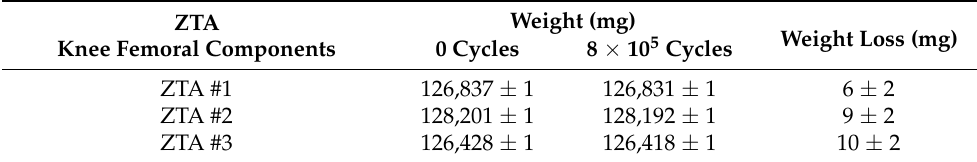
Table 1. Weight and weight loss ( ± instrumental error) of femoral components.